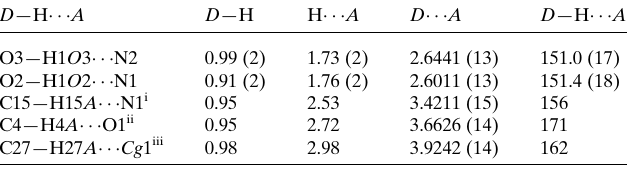
Table 1 Hydrogen-bond geometry (A˚ , (cid:3) ).